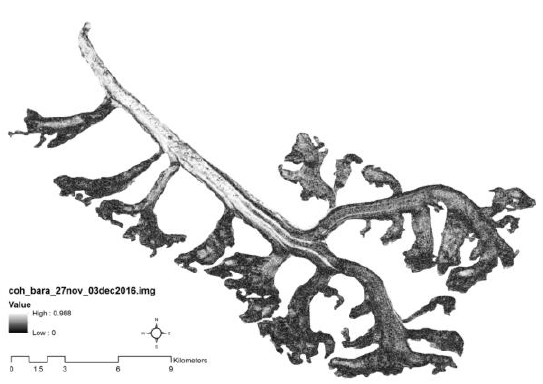
Figure 11: Phase map of Gangotri glacier